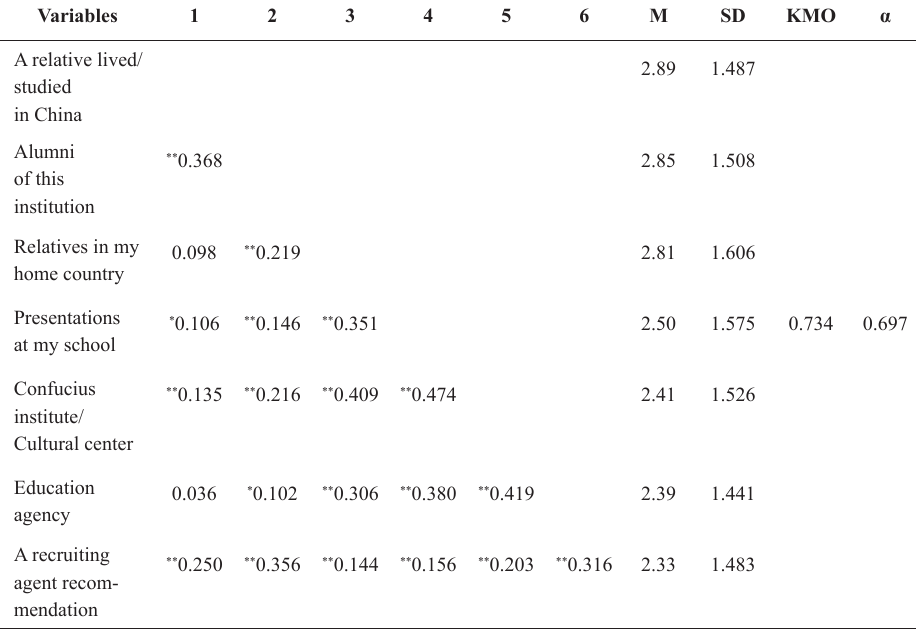
Table 4. African students’ microsystem/interpersonal